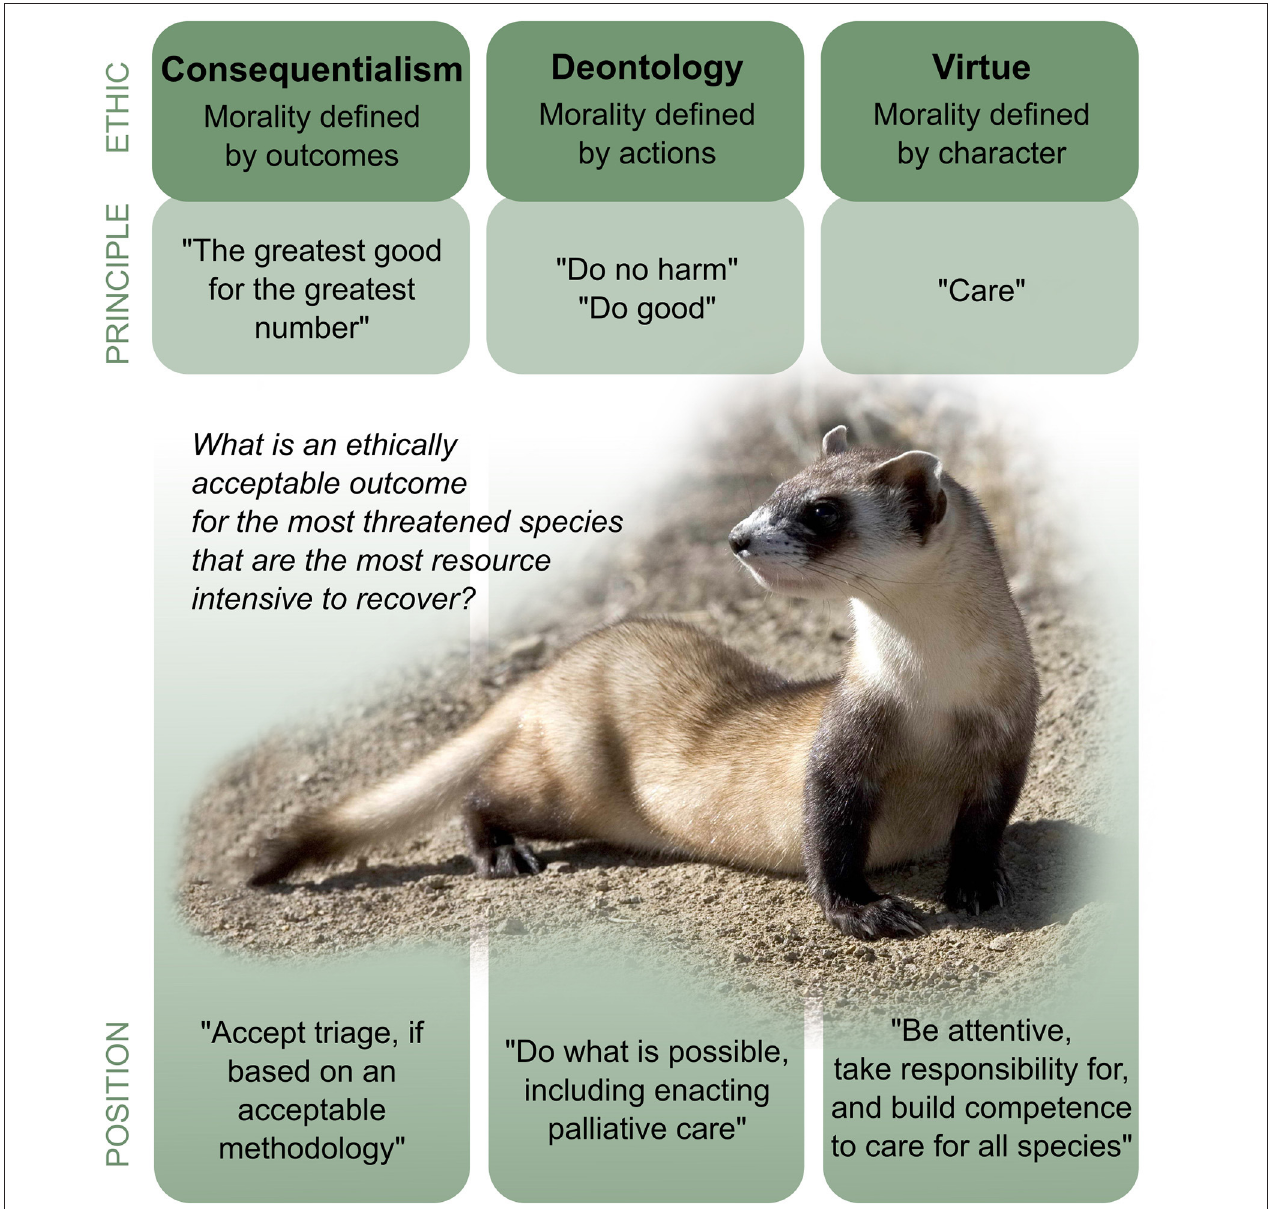
FIGURE 1 | Possible ethical stances in relation to conservation triage. Example principles are given, which may lead to different positions on the triage of critically endangered species, such as the black-footed ferret. Outcomes that may be drawn from these positions are contingent on the context and dependent on subjective